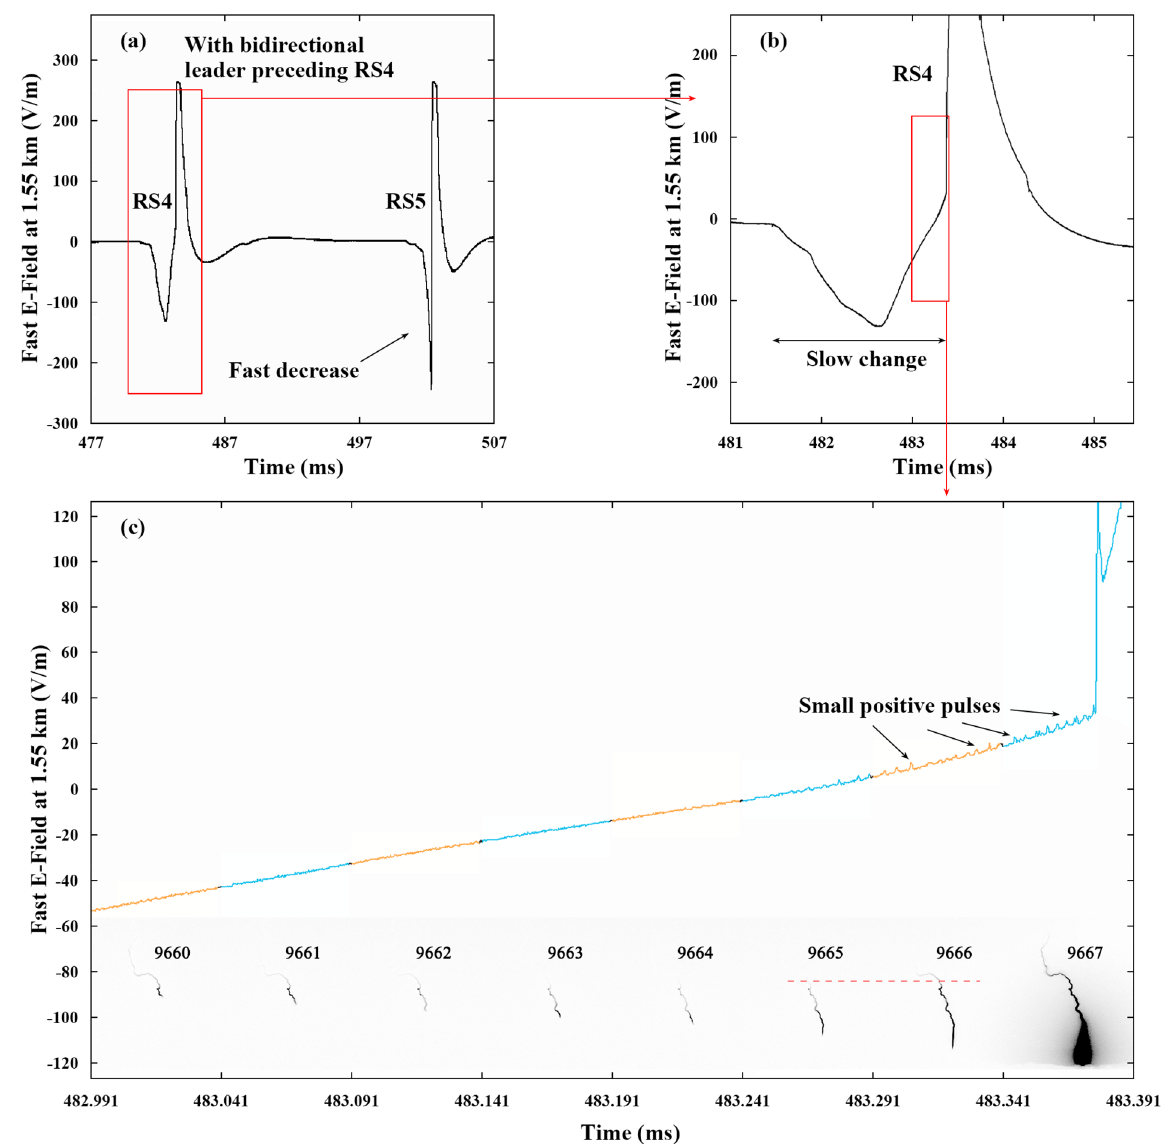
Figure 3. The electric field changes of DL4 at 1.55 km expanded in different time scale. The electric field waveform is colored to match corresponding high-speed frames with an uncertainty of 3.8 μs. The high-speed frames are background removed, intensity inverted and contrast enhanced to show the propagation process